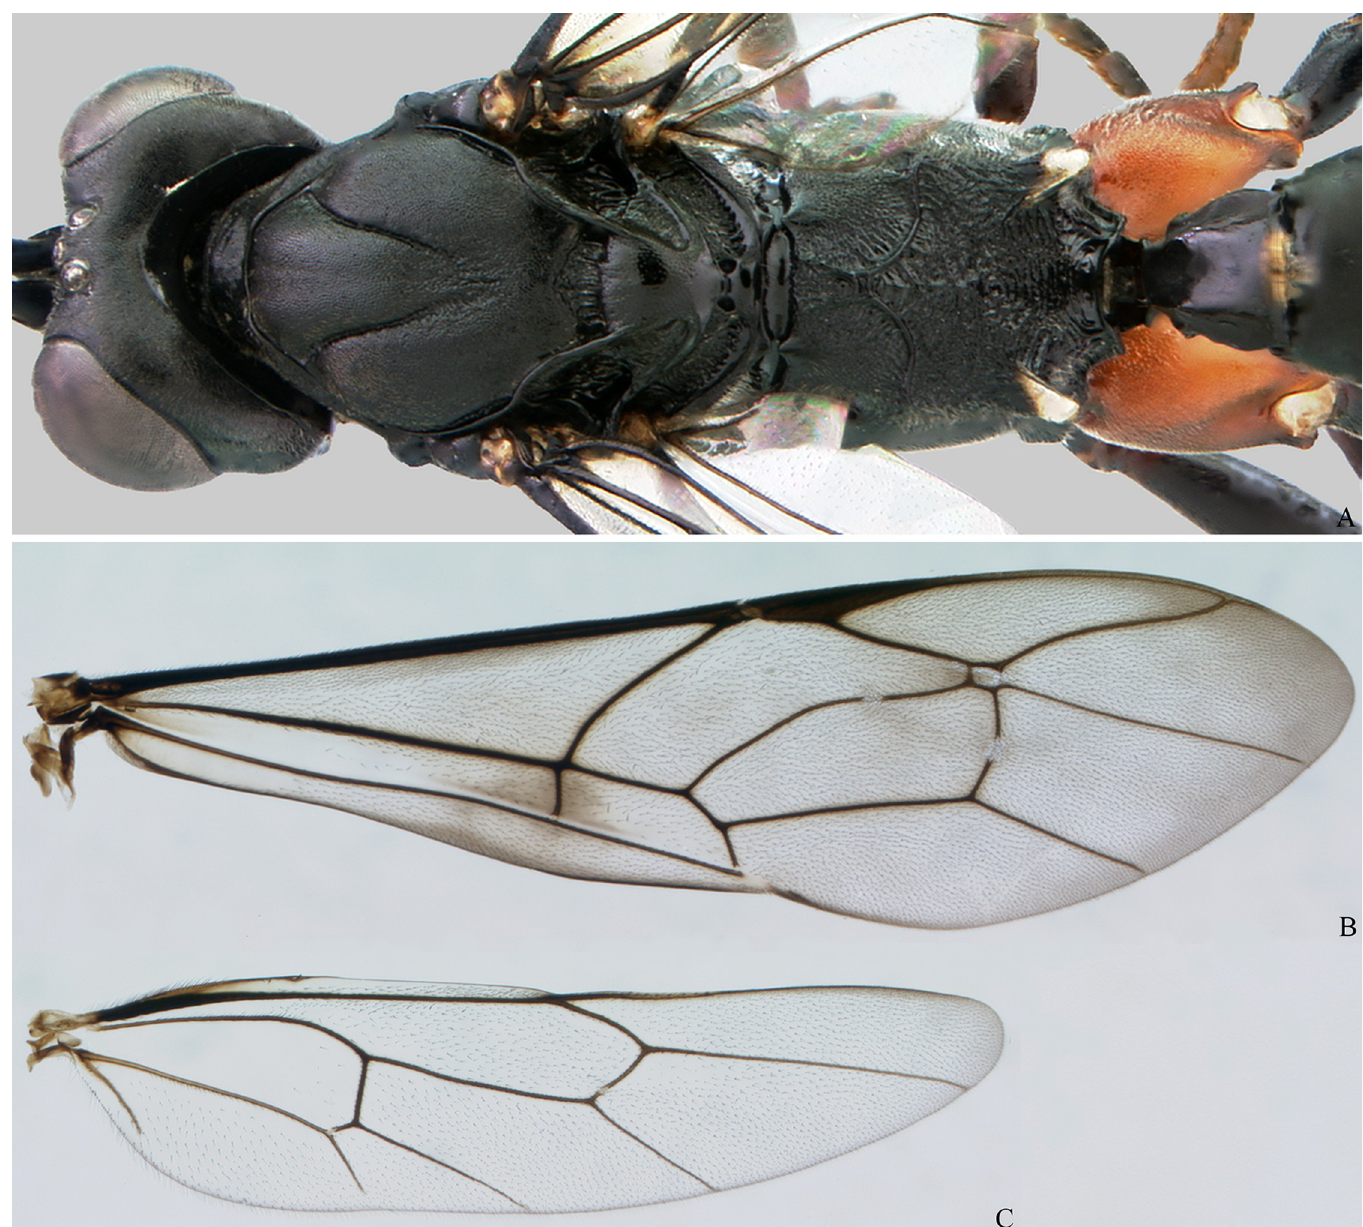
Fig 11. Cryptoxenodon metamorphus sp. nov. Female mesosoma and wings. (A) Mesosoma + first tergite; holotype FAS1127, Alt. 561m, Brazil/ES. (B-C) Fore and hind left wings, horizontally flipped; paratype FAS1131, Alt. 557m, Brazil/ES.